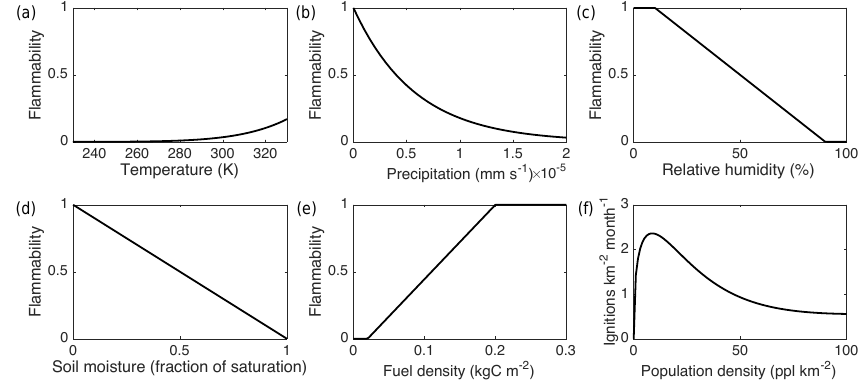
Figure A1. The mathematical functions used for individual dependencies of INFERNO on key driving variables for flammability (a, b, c, d, e) and ignitions (f) , within the range of reasonable Earth observations. Note the population density only influences the model output if ignition mode 3 is selected (interactive lightning and human ignition).